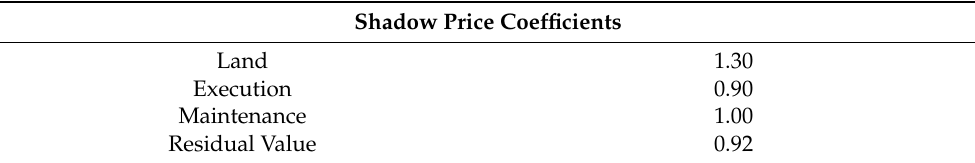
Table 1. Shadow price coefficients for the Spanish case. Own elaboration, based on